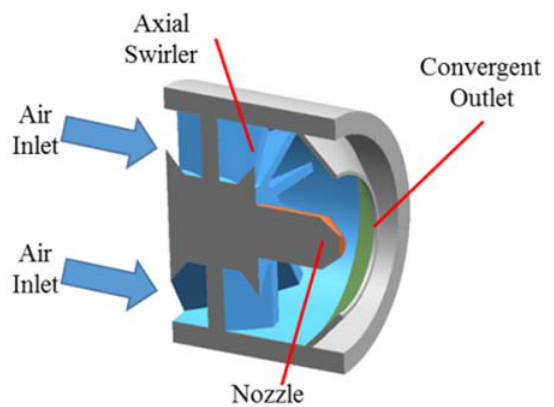
Figure 1. The LDI module.